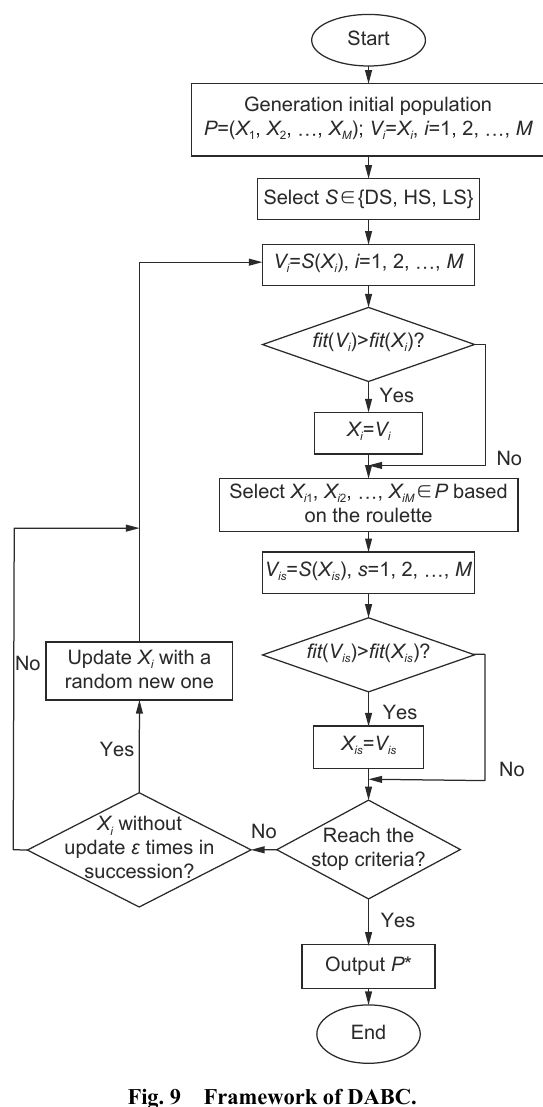
Fig. 9 Framework of